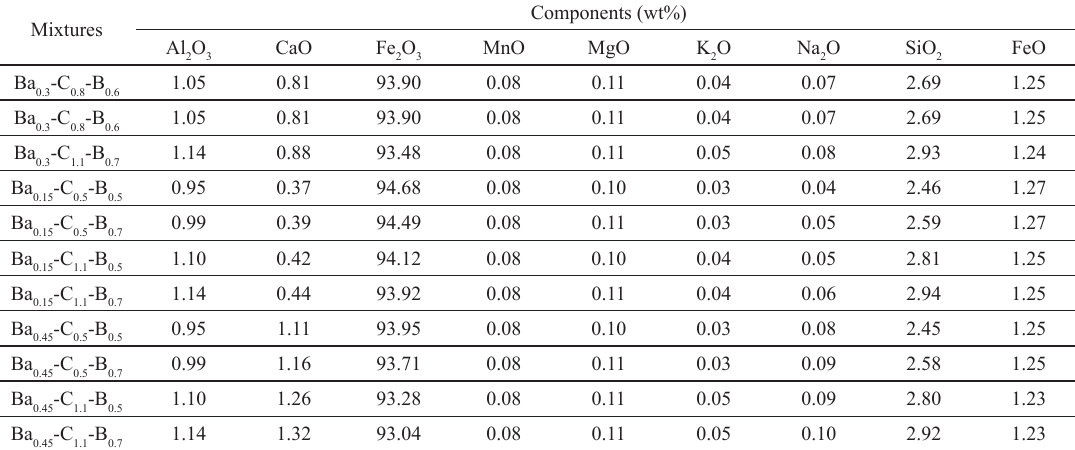
Table 2. Chemical composition of the iron-ore pellets obtained for mass balance used in thermodynamic simulations. Mixtures